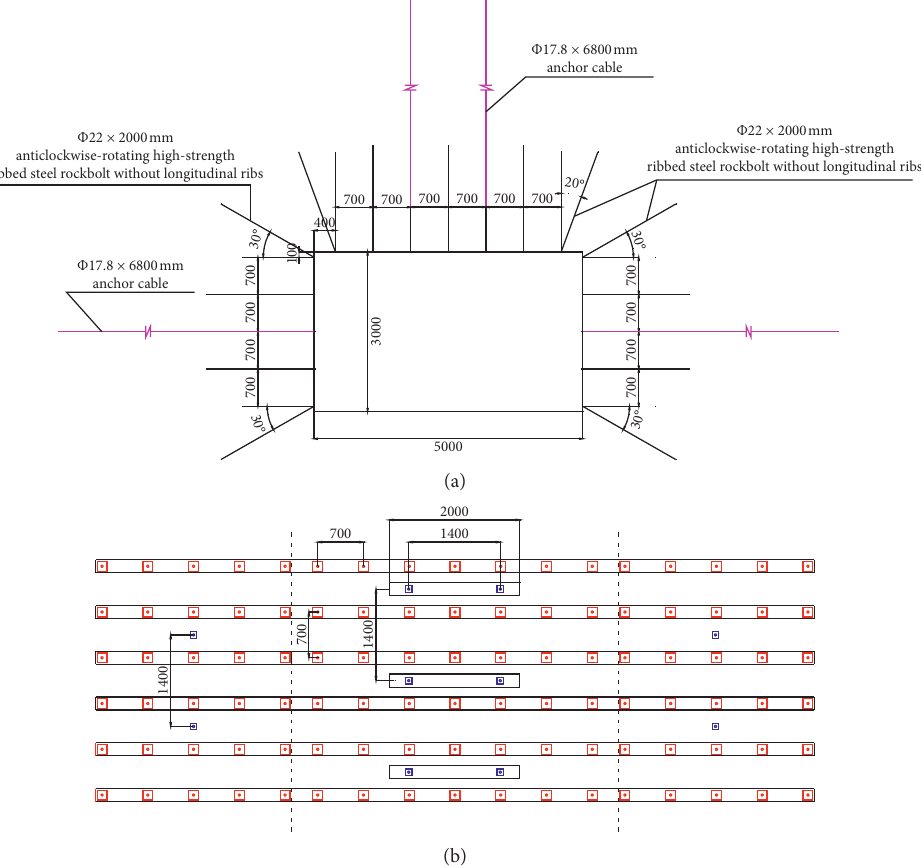
Figure 14: Roadway-support plan. (a) Cross section of support (unit: mm). (b) Expanded view of support (unit: